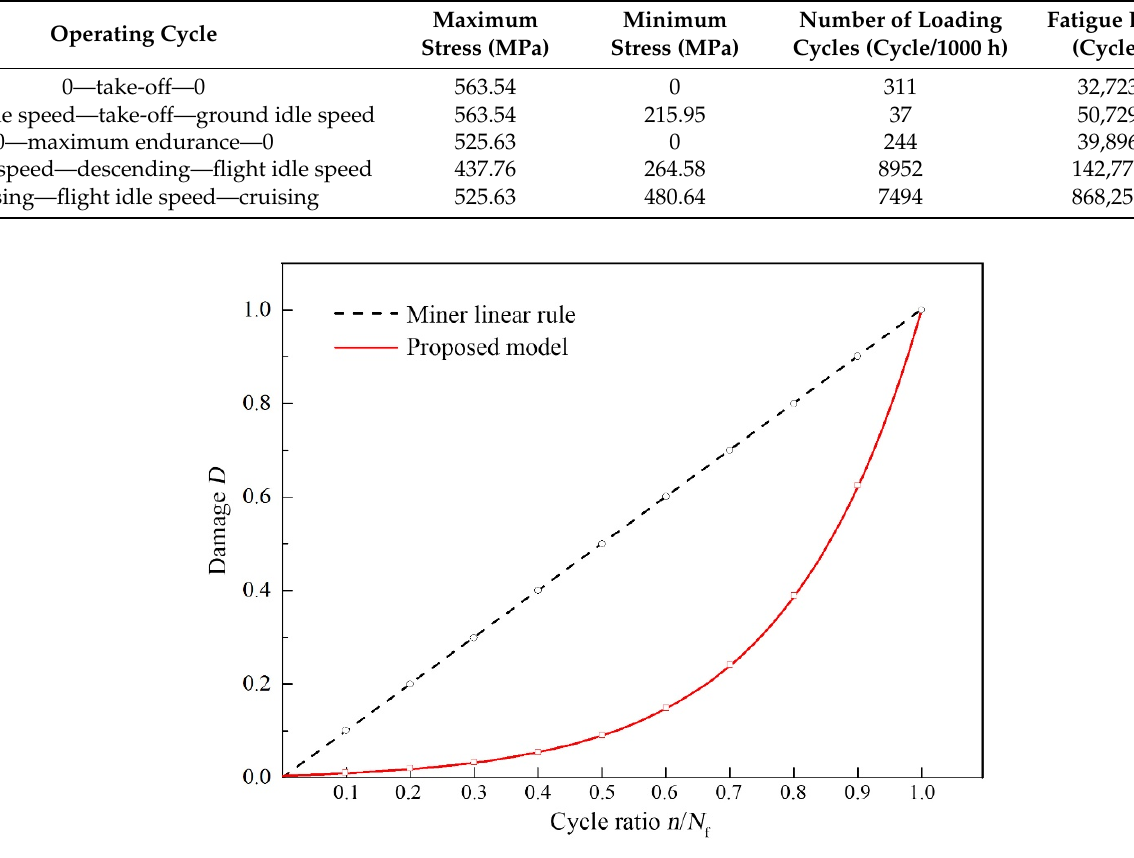
Figure 18. Comparisons of damage accumulation curves of different models. Table 4. The fatigue loading spectrum of the blade in typical engine conditions.